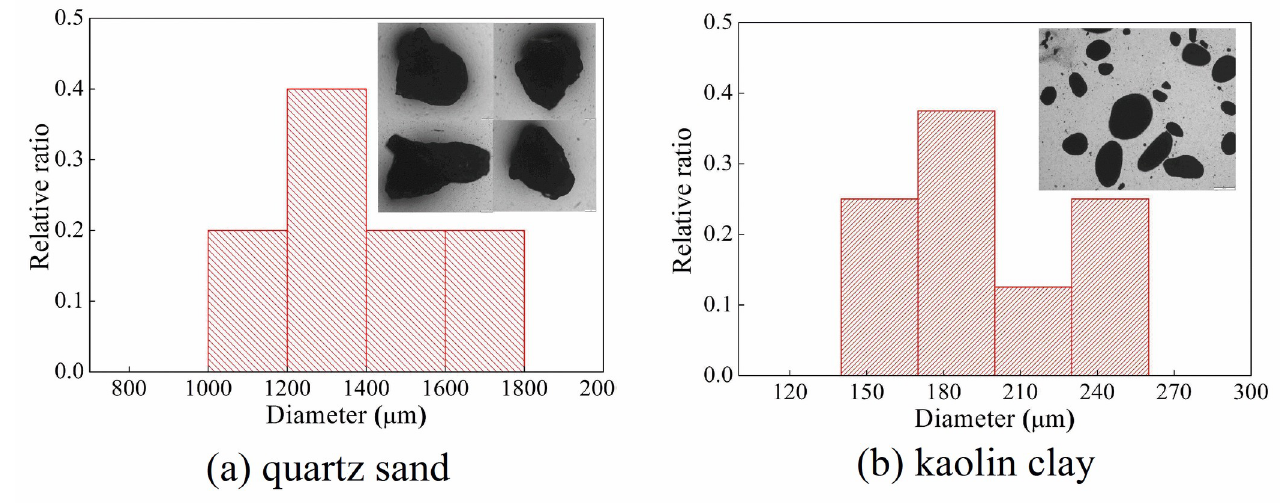
Fig 8. Joint-filling materials. (a) quartz sand (b) kaolin clay.